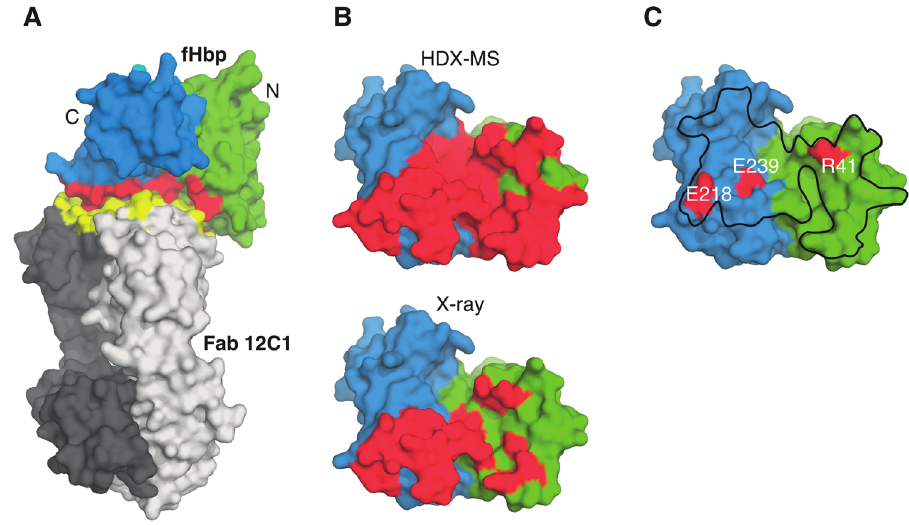
Figure 2. ( A ) The crystal structure of the complex fHbp-Fab 12C1 (pdb 2YPV) is depicted with green/blue surface for N and C termini of fHbp, and light/dark gray for light and heavy chains of Fab 12C1. The epitope and paratope surfaces are colored in red and yellow, respectively; ( B ) Surface representations of fHbp (colored as in panel A ), allowing comparison of the Fab 12C1 epitope (red patch) as revealed by HDX-MS ( top ) and X-ray crystallography ( bottom ). For clarity, the surface of fHbp only is shown, after re-orientation (~90° about the Y -axis) of the view in A ; ( C ) Surface locations of fHbp residues (red patches, labeled) which when mutated to Alanine inhibit human fH binding. The entire interface of the interaction with fH on the surface of fHbp is outlined with a black line, as revealed previously